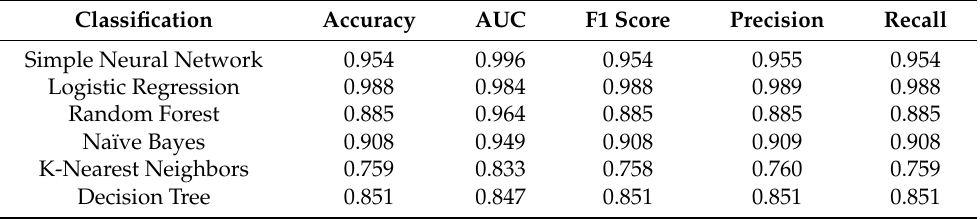
Table 3. Table showing the success of different algorithms based on classification accuracy and other metrics. Table above indicates several classification metrics relating to logistic regression, decision tree, random forest, naïve bayes, k-nearest neighbors, the “out of the box” neural network in Orange. These results are reflective of many runs, which generally give a classification accuracy of about 75–99%. Please note that both the classification accuracy and the area under the (ROC) curve are high for nearly all methods. Misclassifications in the confusion matrices were generally